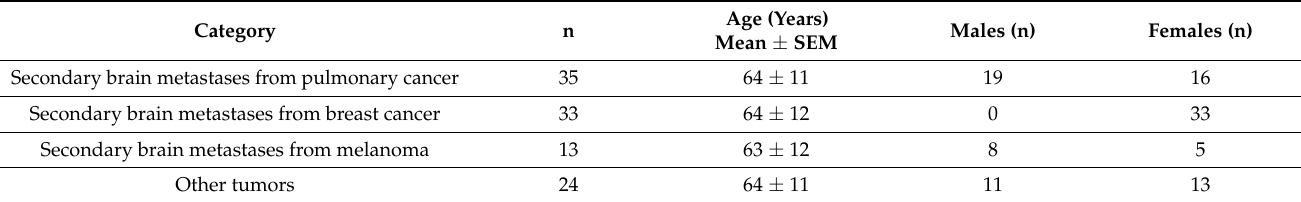
Table 4. Demographic and clinical features of patients with brain metastases